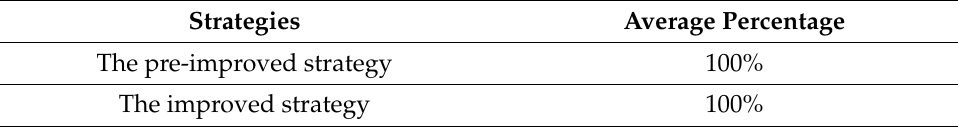
Figure 21. The valid positioning results given by different algorithms. Table 8. The percentage of valid positioning results given by different integration